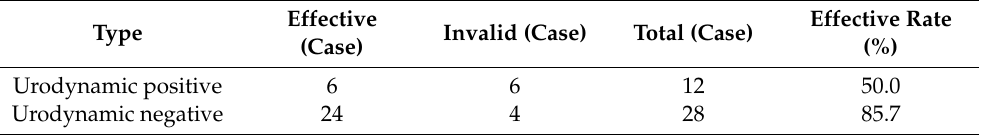
Table 4. Effective rate of postoperative UUI symptoms in urodynamic positive patients and urody- namic negative patients. (Case expressed in